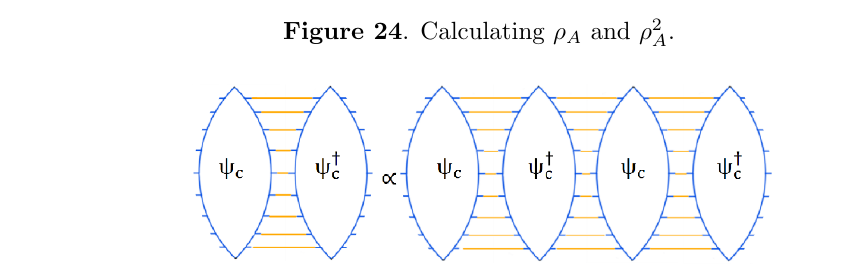
Figure 24 . Calculating (cid:26) A and (cid:26) 2